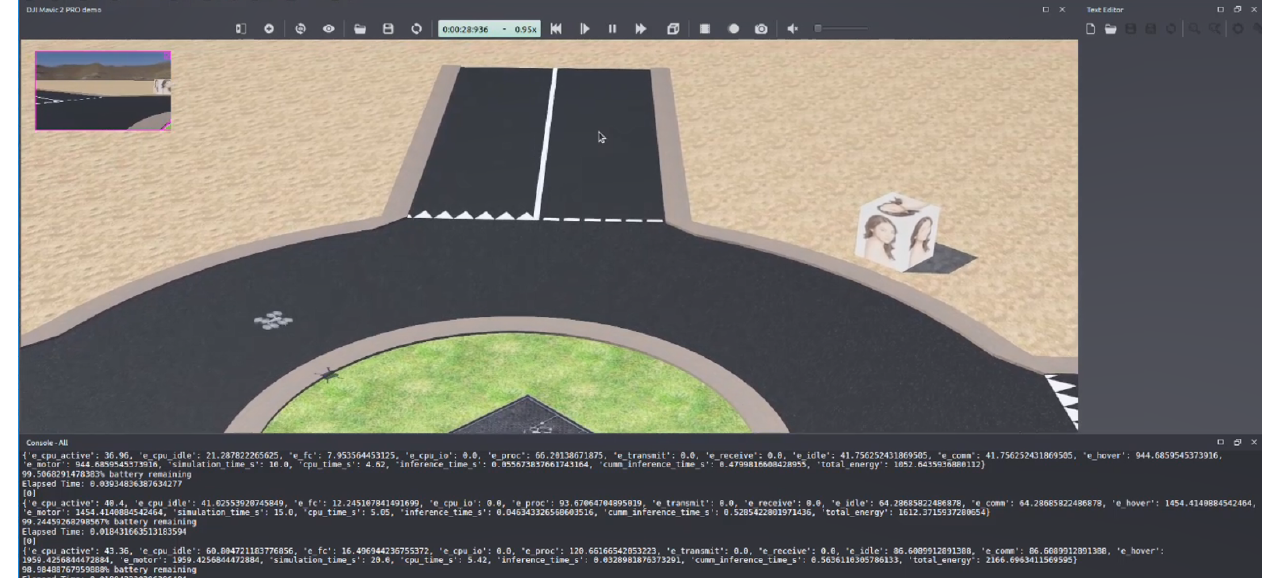
Figure 1. Screenshot from FlockAI with a drone deployed to perform object